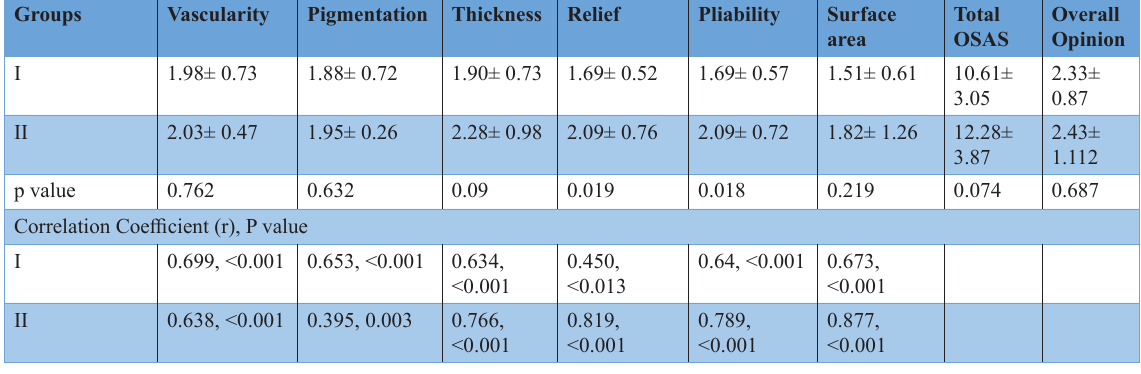
Table 4 Comparison of mean scores with standard deviation of the OSAS items between groups and Correlation between Observer Opinion and Observer